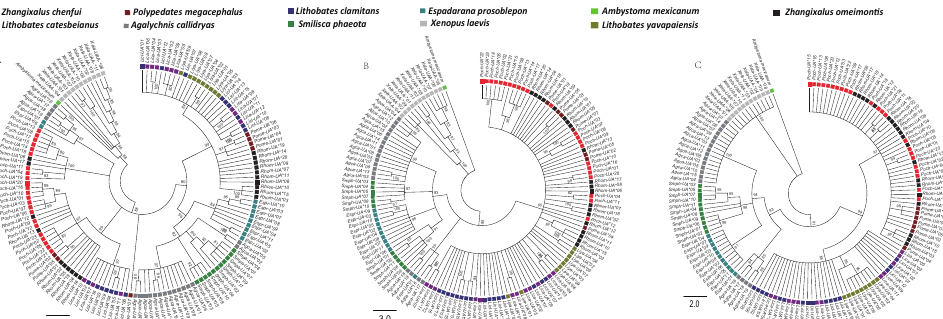
Figure 5. Phylogenetic relationships of α 1 ( A ), α 2 ( B ) and α 3 ( C ) domains. Bayesian posterior probabilities are presented. All of the branches are proportional to the scale shown at the bottom left. Alleles belonging to di ff erent species are marked using di ff erent